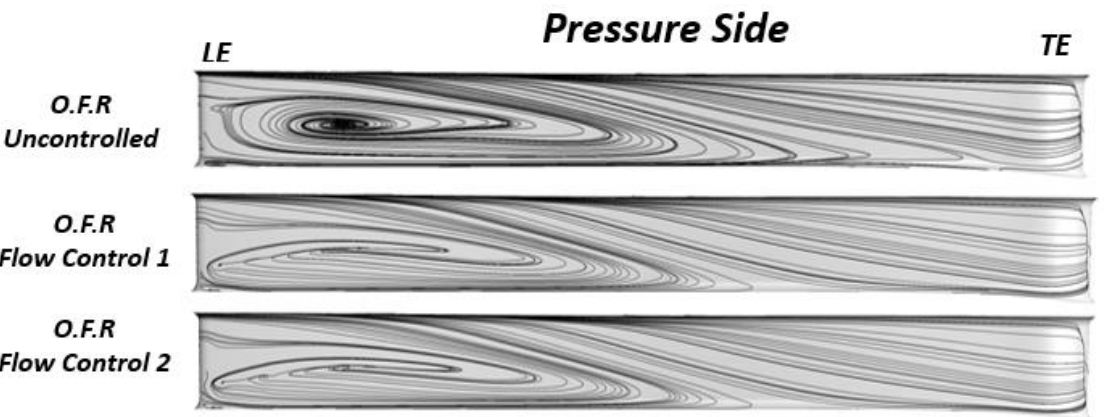
Figure 8. Surface streamline comparison of different suction control studies at operation flow rate.